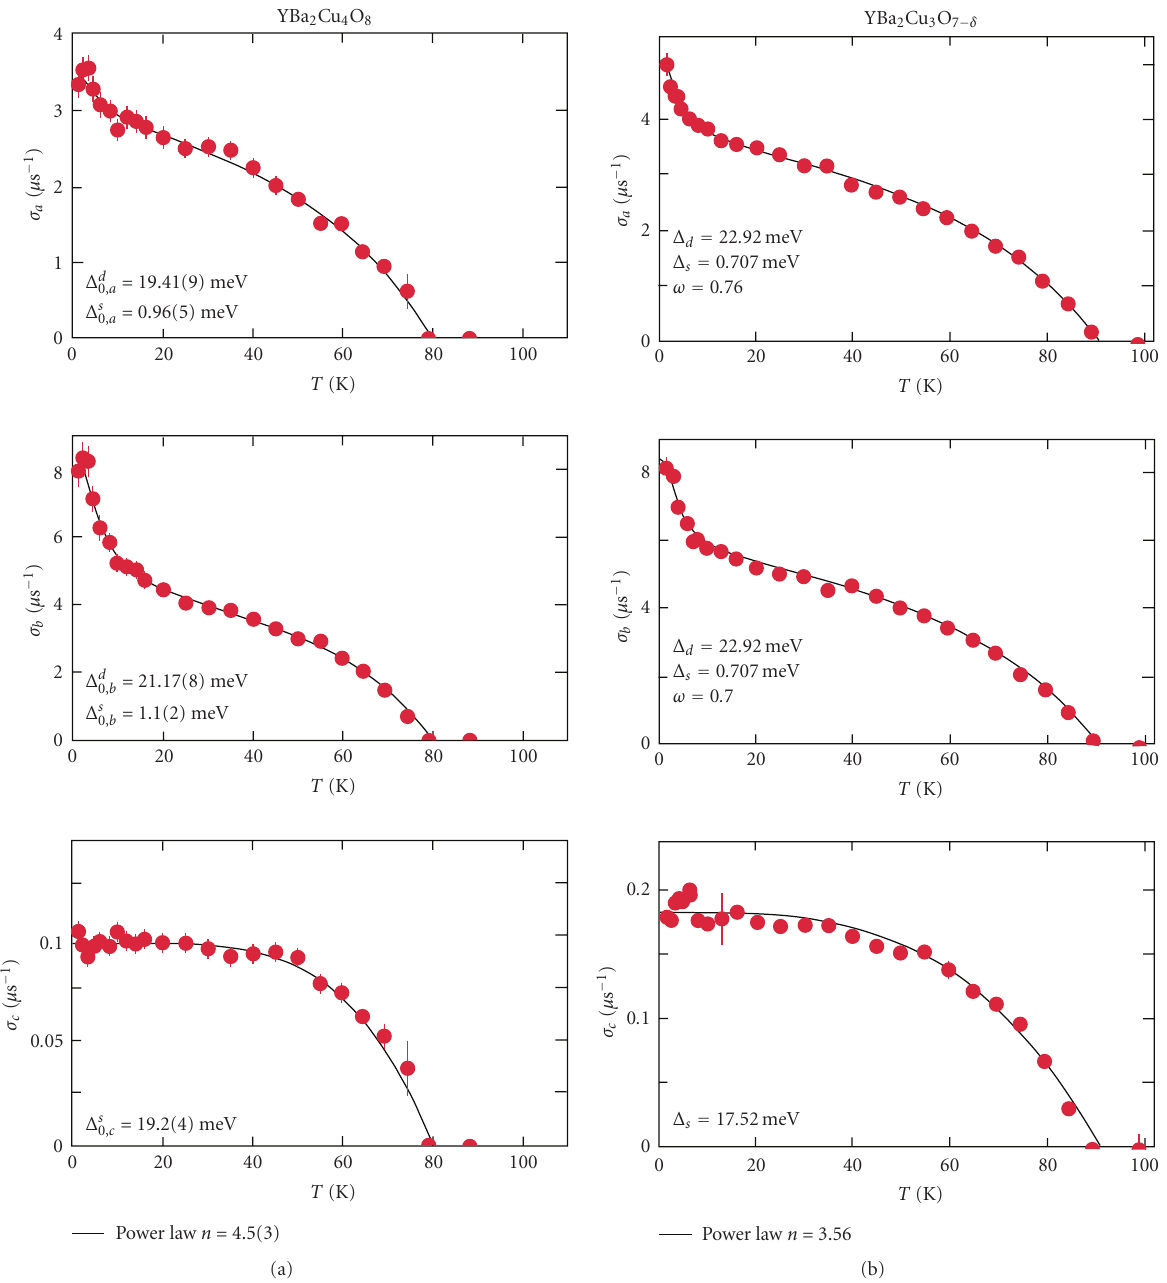
Figure 10: (a) Temperature dependences of the μ SR relaxation rate σ a ∝ λ − 2 measured along the three principal crystallographic axes a , b , c . (b) Temperature dependence of the μ SR relaxation rate σ a ∝ λ − 2 of single crystals of YBa 2 Cu 3 O 7 − δ measured along the three principal crystallographic axes a , b , c . The lines in (a) and (b) are and σ c ∝ λ − 2 c results from model calculations as discussed in [22–25], after